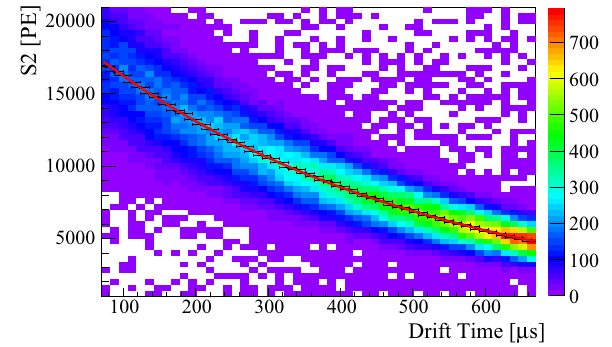
Fig. 18 The loss of electrons due to the presence of electronegative impurities in the LXe is measured via the drift time-dependent decrease of the charge signal size, e.g., from the mono-energetic 32.1keV line from 83 m Kr. The example shown here corresponds to an electron life- time τ e = ( 467 ± 5 ) µ s, derived from the exponential fit (red line)